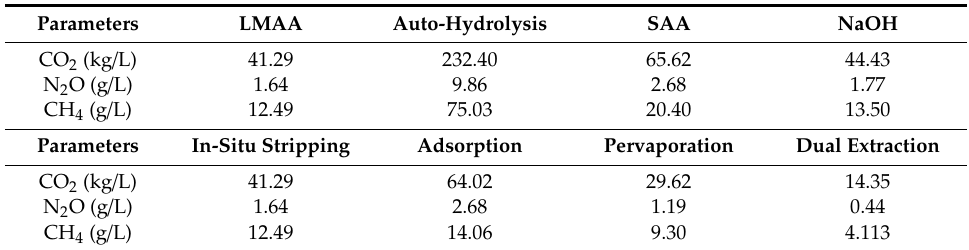
Table 11. Biogenic emissions from cellulosic butanol production plants employing 100% biomass-fueled combined heat and power (CHP) system.